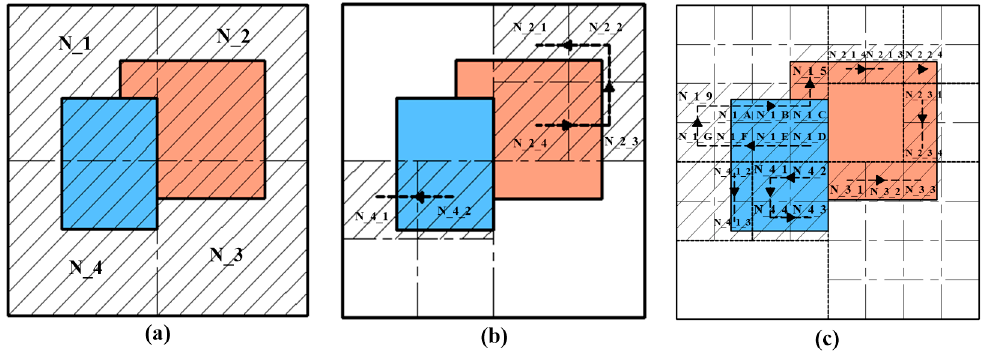
Figure 4. ( a – d ) The divided sub-regions and scanning trajectories of the region N_1–N_4. Figure 5. ( a – c ) Scanned sub-regions and scanning trajectories in the scanning step from T_1 to T_3.